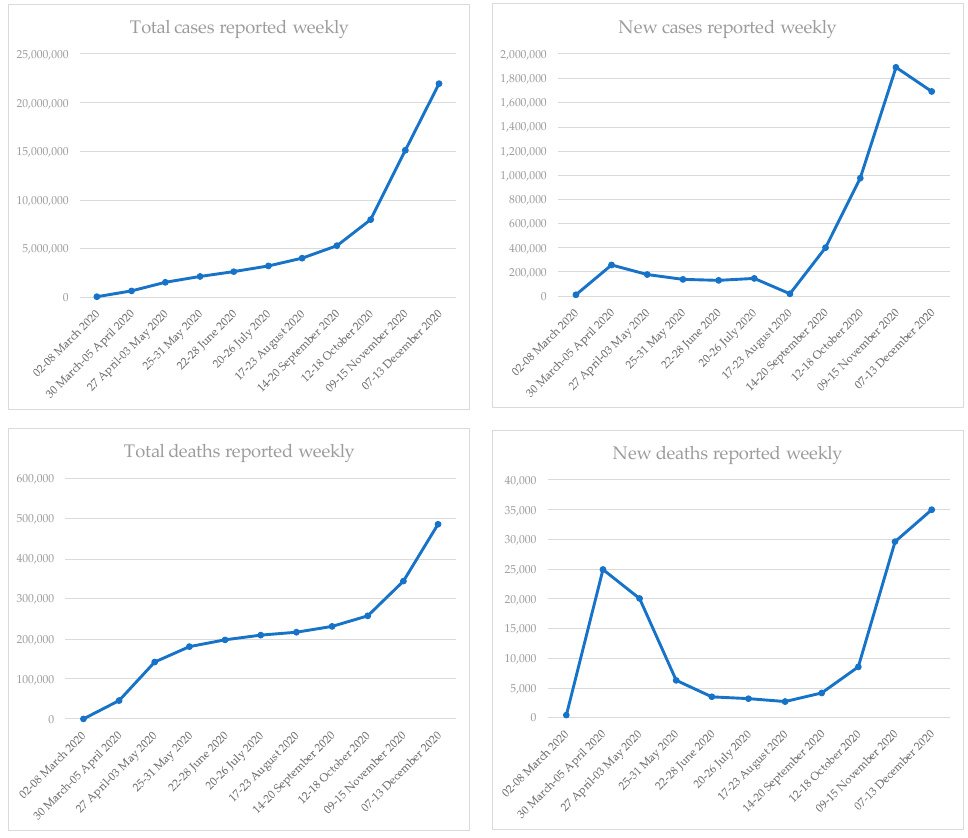
Figure 1. Trend of COVID-19 cases and deaths in EU/EEA region, 2 March 2020–13 December 2020 (modified from [13,14,30–38]).